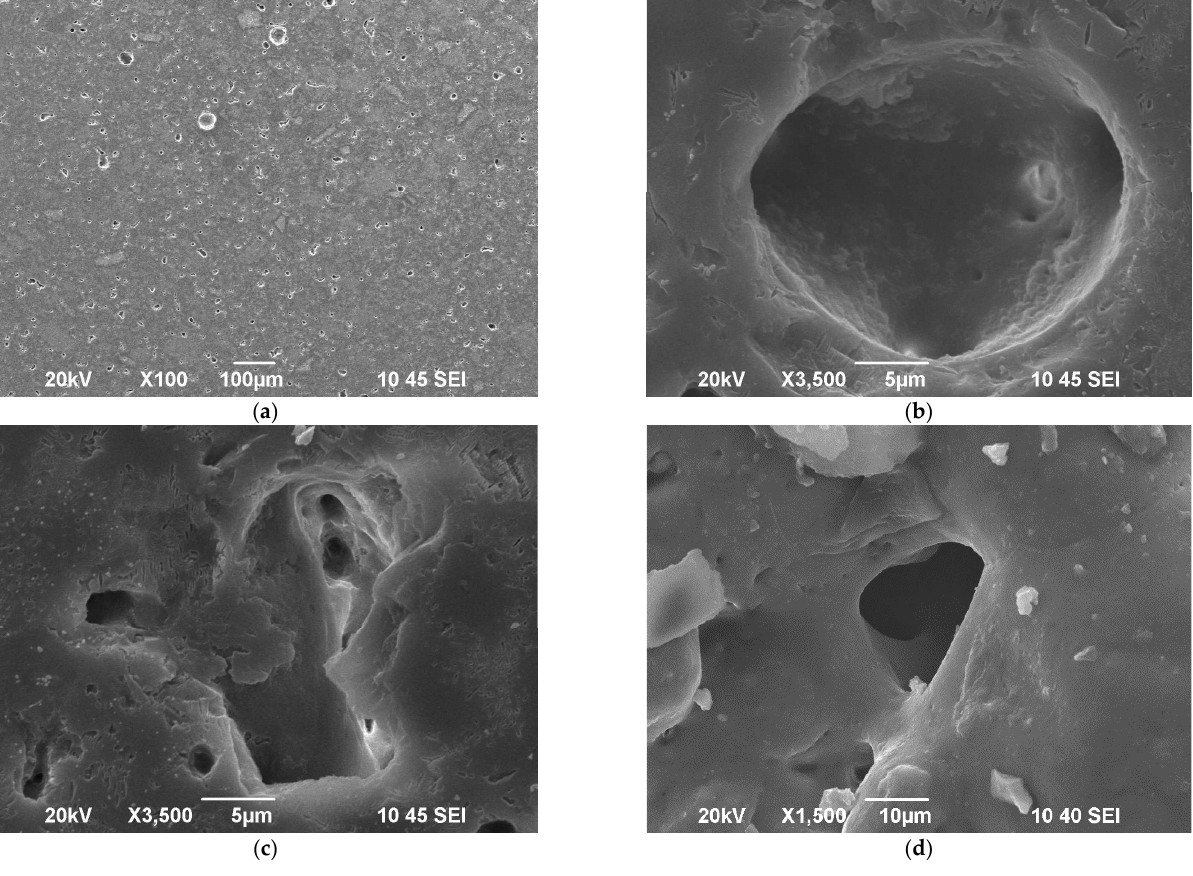
Figure 4. SEM images of polished samples at different magnifications: ( a – c ); Single pore formed on the surface, ( d ).